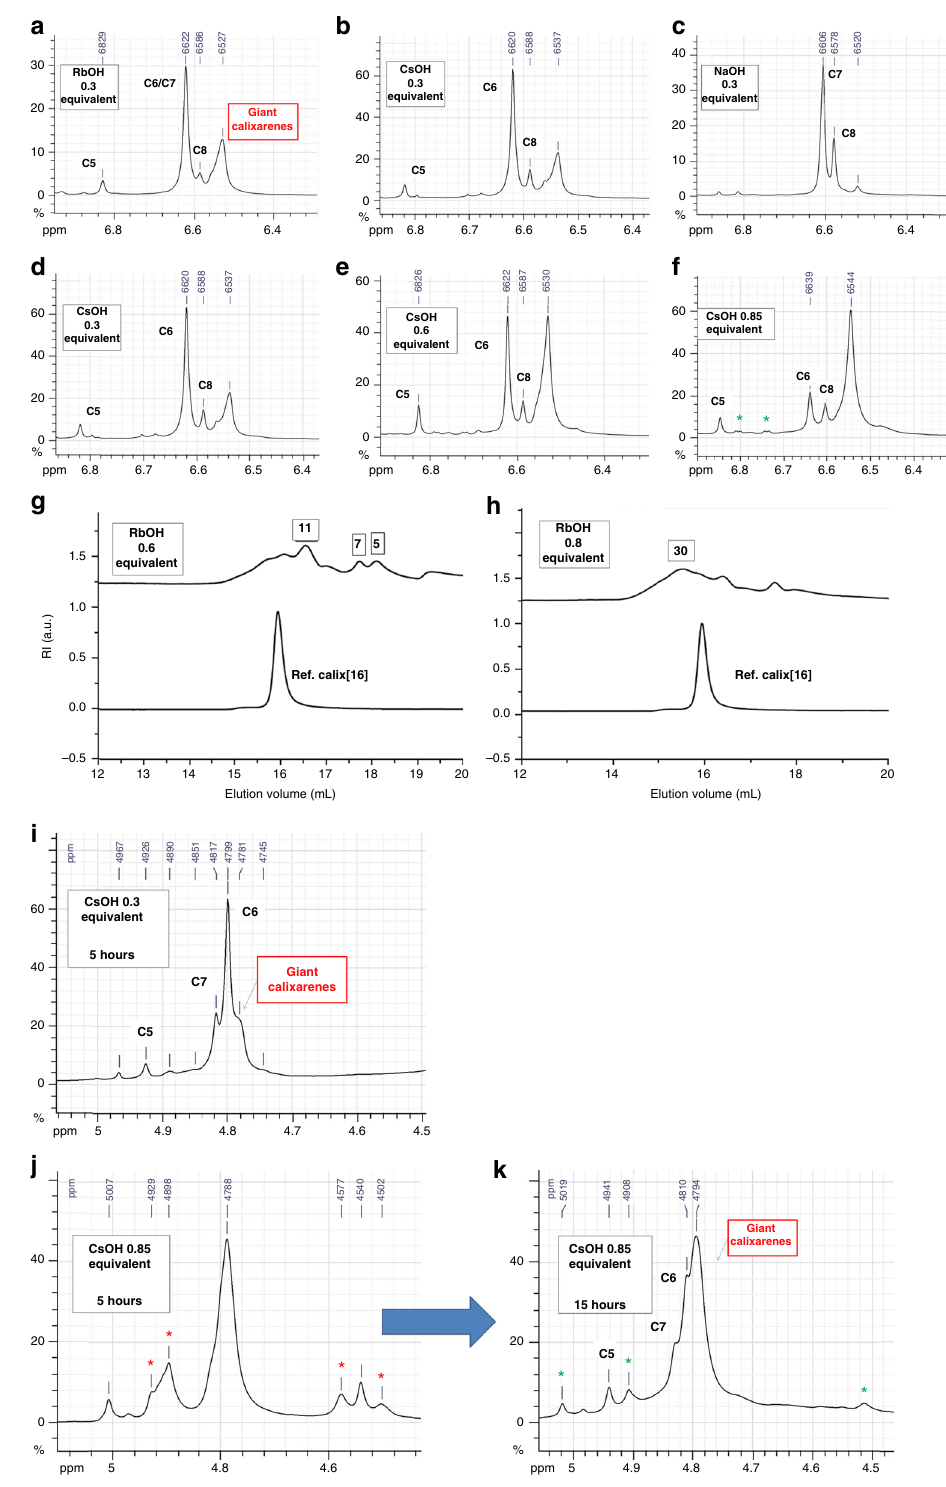
Fig. 8 In fl uence of relevant reaction parameters on the yield and size distribution of giant calixarenes. a , b , c evolution of the 1 H NMR spectra (DMSO-d6; hydroquinone-type protons area) of crude products obtained with different bases (one-step process used for all examples); d , e , f evolution of the 1 H NMR chemical spectra of the hydroquinone-type protons of crude products obtained using increasing concentrations of CsOH (one-step process); g and h SEC comparison of two crude samples obtained using different base/phenol ratio. Number of PRUs shown in the boxes. The green asterisks are highlighting bis (homooxa) p -(benzyloxy)calix[4]arene. 1 H NMR (DMSO-d6) comparison between low ( i ) and high ( j ) base/phenol ratio, and between low ( j ) and high ( k ) re fl uxing times. Green asterisks: p -(benzyloxy)bishomooxacalix[4]arene; red asterisks: linear oligomers